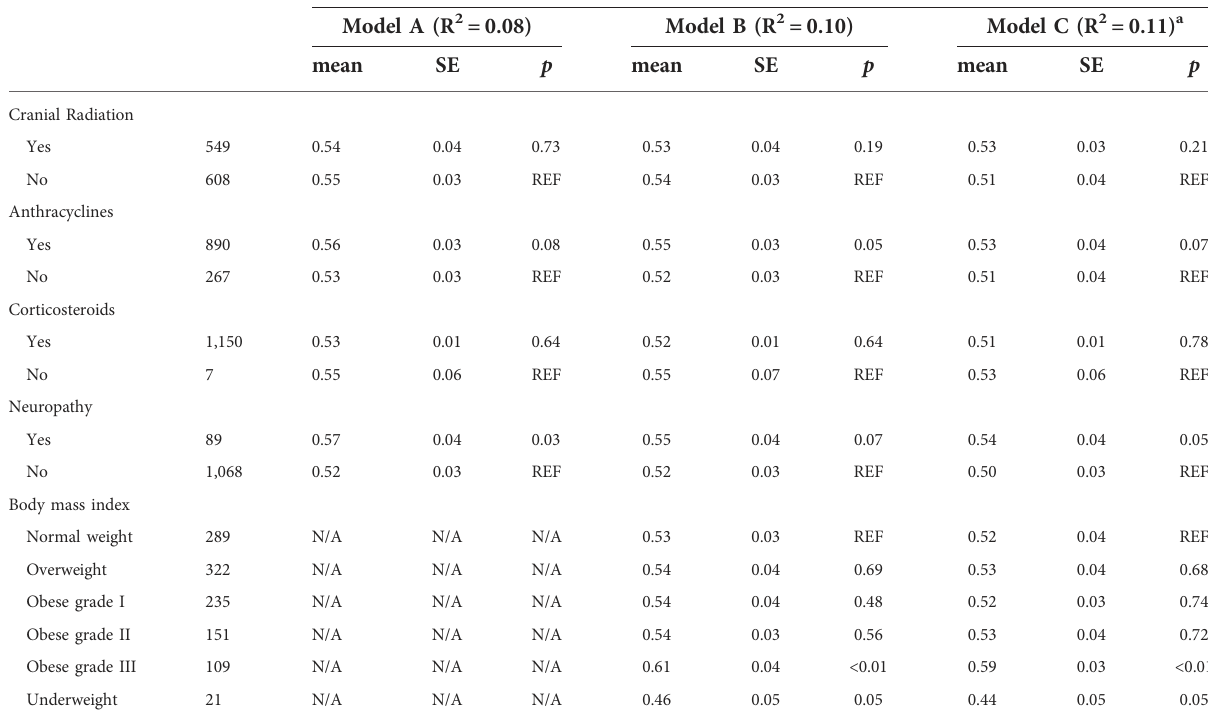
TABLE 3 Sequential linear regressions examining associations between treatment exposures, BMI, prevalent neuropathy, and lifestyle factors on physiological cost index in adult survivors of childhood acute lymphoblastic